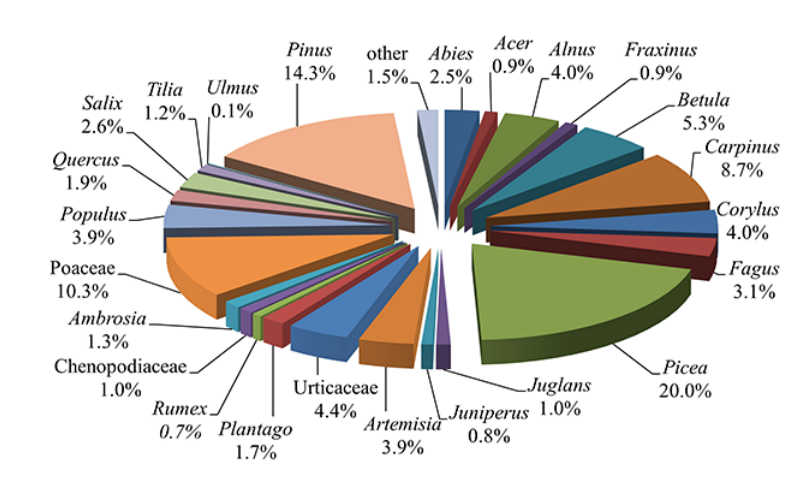
Figure 3 Aeropalynological spectrum of Ivano-Frankivsk in 2013.